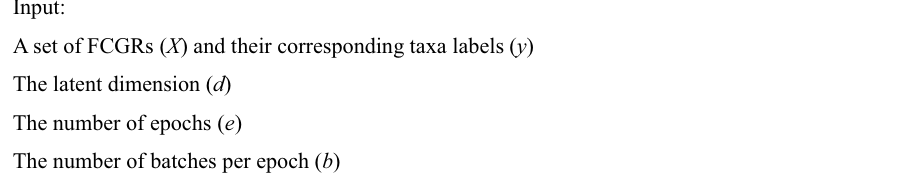
Algorithm One – A simple overview of the steps involved in training the